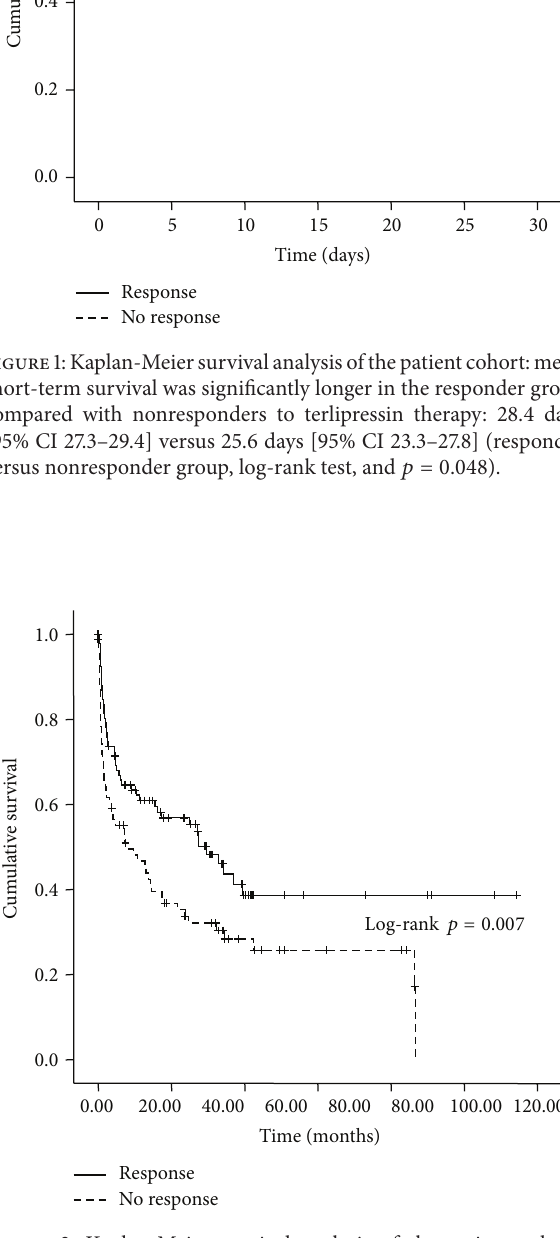
Figure 4: Kaplan-Meier survival analysis of the patient cohort: mean short-term survival was significantly longer in group with treatment duration > 18 days compared with those less than 18 days treated: 29.2 days [95% CI 28.4–30.0] versus 23.4 days [95% CI 20.9– 25.9] (treatment days ≥ 18 versus treatment days < 18 days, log-rank test, 𝑝 < 0.0001